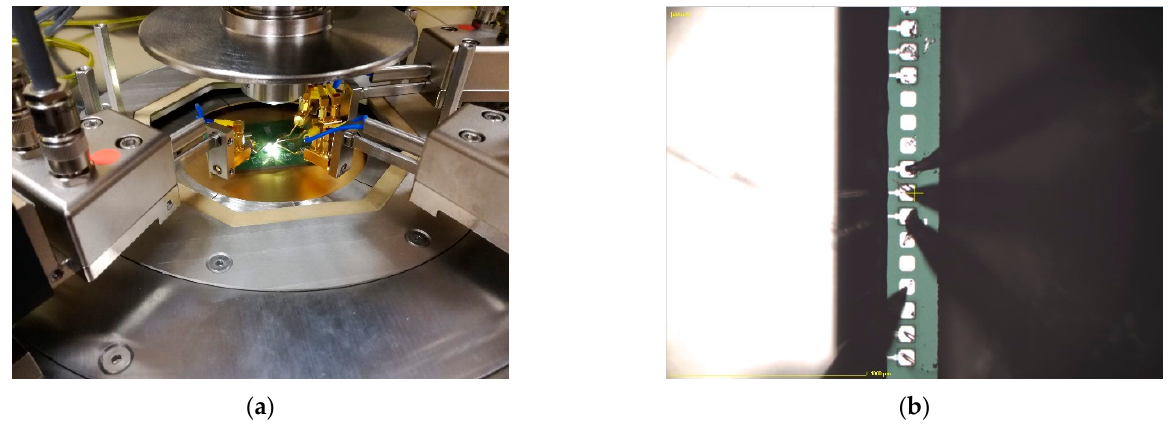
Figure 10. The measurements of the naked die performed on the probe station. General view of the device on the probe station ( a ). Zoom of the probes placed on the chip’s pads ( b ).